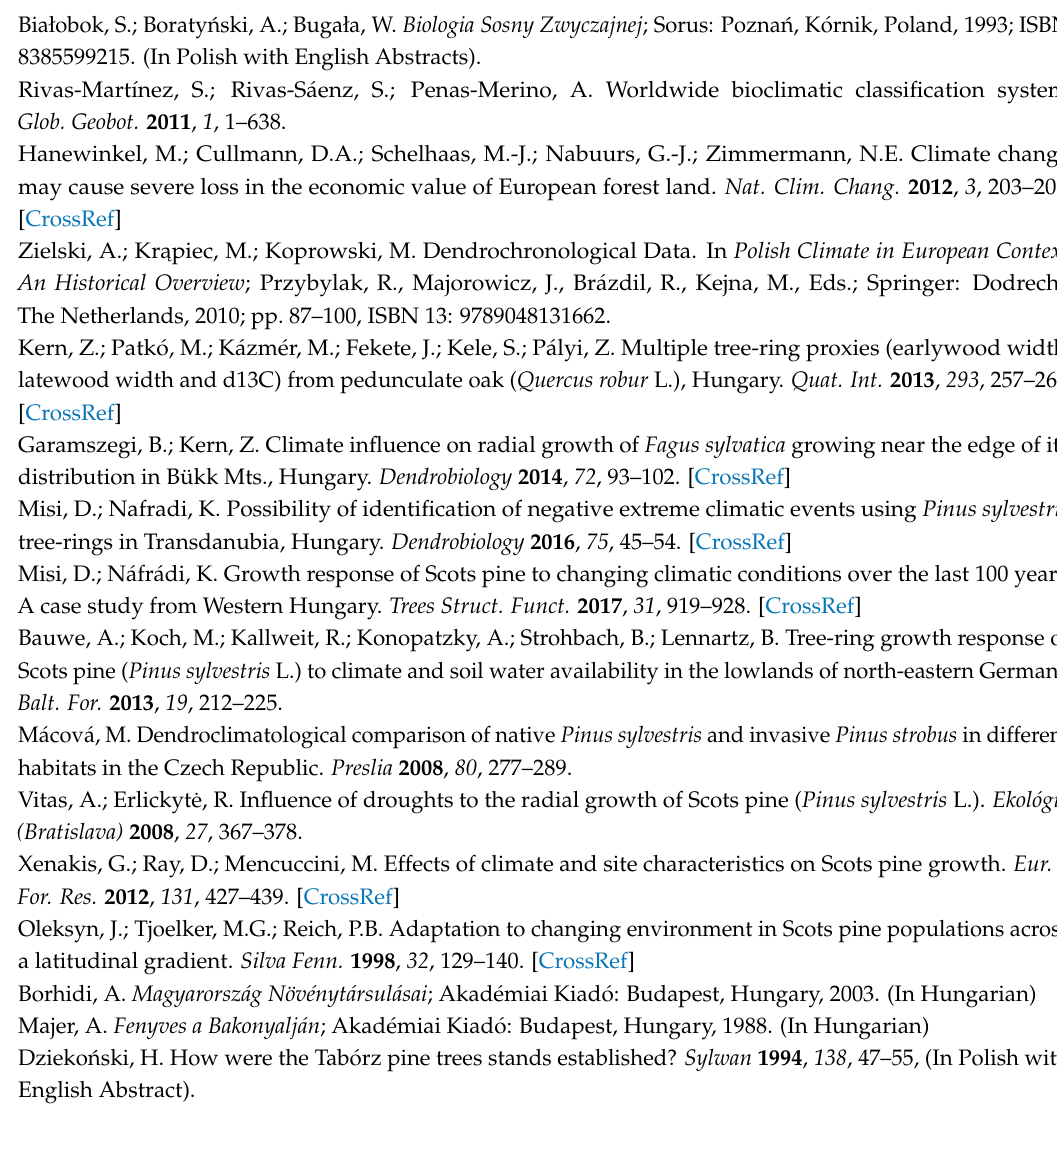
s1, Figure S1. Comparative analysis of the most limiting BIOCLIM [19] values: black square–Feny˝of˝o; black dot–Tab ó rz; grey dots–273 localities from all distribution range of P. sylvestris ssp. sylvestris taken from Conifers of the World database [25]. Elipses indicate 95% variability of climatic values for all sampling sites. Figure S2. Changes in the sum of precipitation from June to July at Feny˝of˝o (solid line) and the Mazury Lakeland (dashed line). The mean correlation (r) between sites is 0.46 ( p < 0.05). Figure S3. Changes in the mean of temperature from February to March at Feny˝of˝o (solid line) and the Mazury Lakeland (dashed line). The mean correlation (r) between sites is 0.93 ( p <